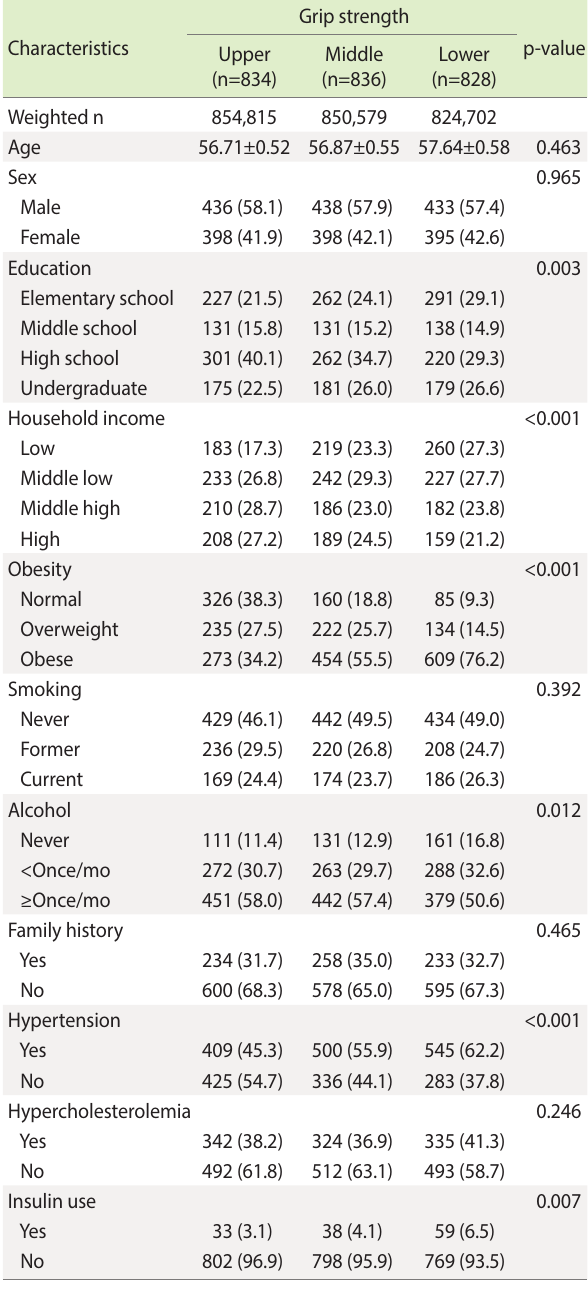
Table 1. Characteristics of participants in the KNHANES 2014-2019 according to grip strength tertiles